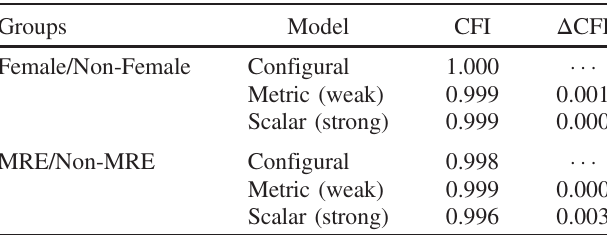
TABLE IV. CFI and Δ CFI for Study 2 invariance